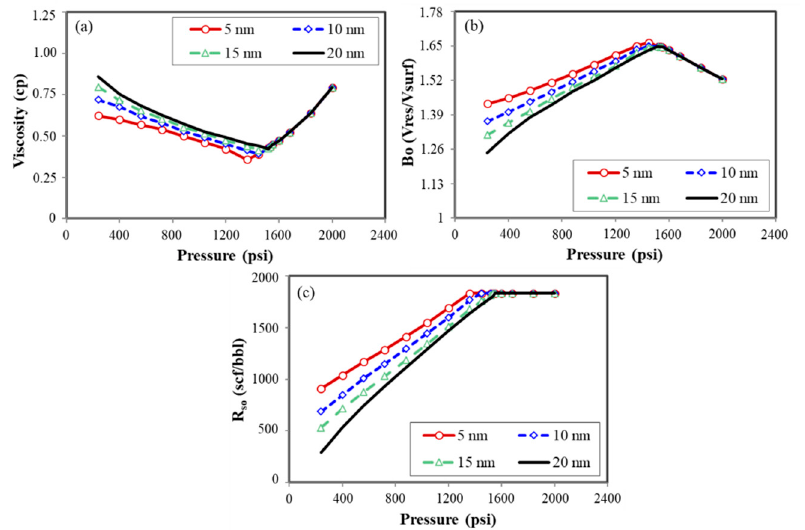
Figure 4. PVT properties of the fluid in the Eagle Ford formation. ( a ) Oil viscosity; ( b ) Bo; ( c ) GOR.